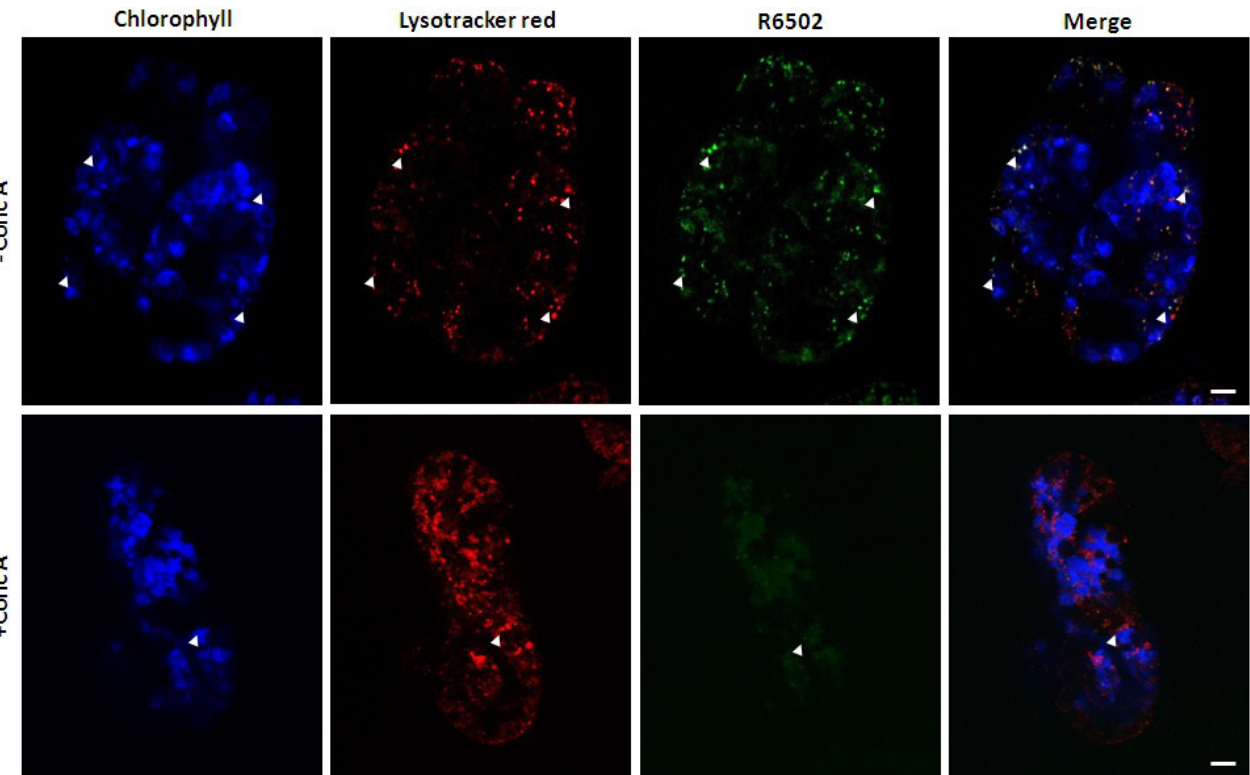
Figure 4. Inhibition of SAVs proteolytic activity by concanamycin-A. Detached tobacco leaves were induced to senesce by incubation in darkness for 3 days, then 5-mm diameter disks were excised and incubated in 1 µm concanamycin-A for 15 h. Cells were stained with Lysotracker Red and R6502 and observed through laser confocal microscopy. Note the almost complete disappearance of the characteristic punctuate pattern of R6502 ( i . e ., proteolytic activity) corresponding to SAVs in cells from disks treated with concanamycin-A (lower